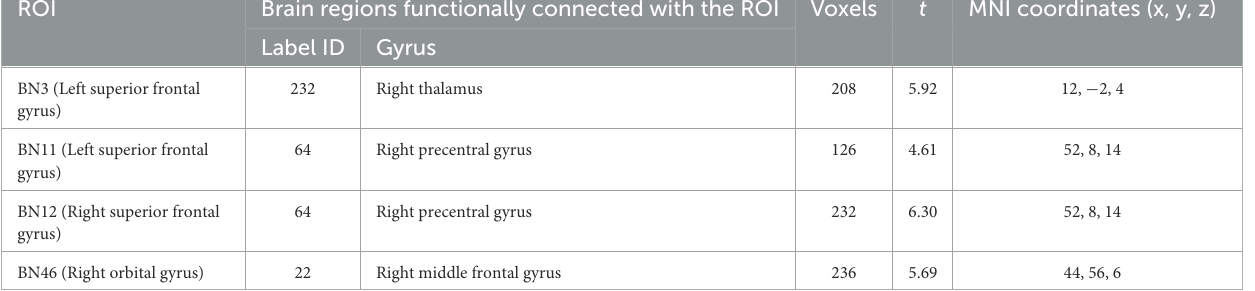
TABLE 2 Functional connections (neglect group > control group) significantly correlated with the questionnaire data ( n = 45).